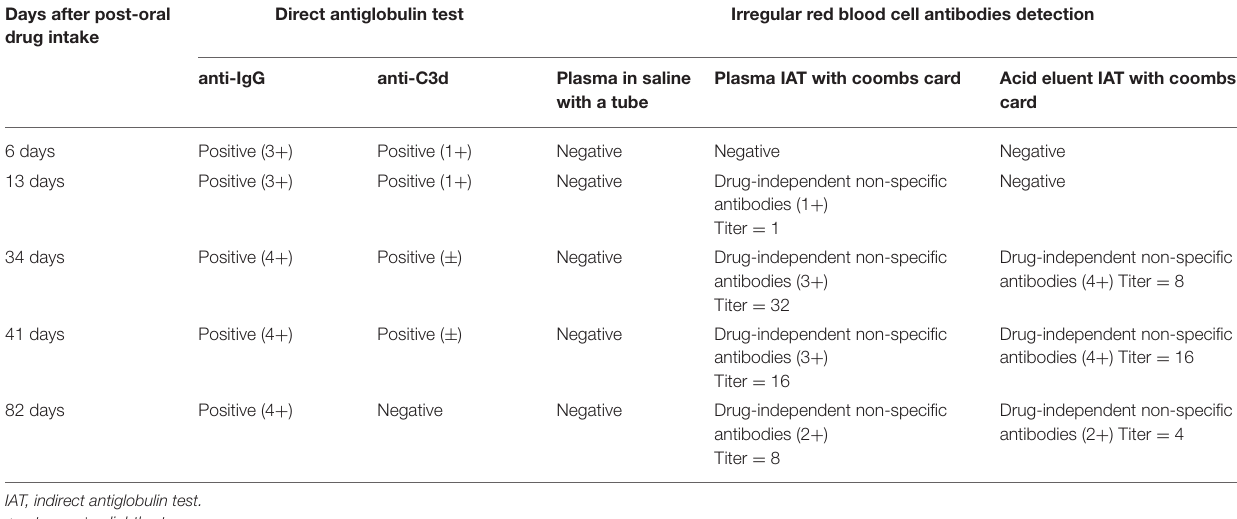
TABLE 1 | Results of DAT and irregular RBC antibodies detection in plasma and acid eluent.